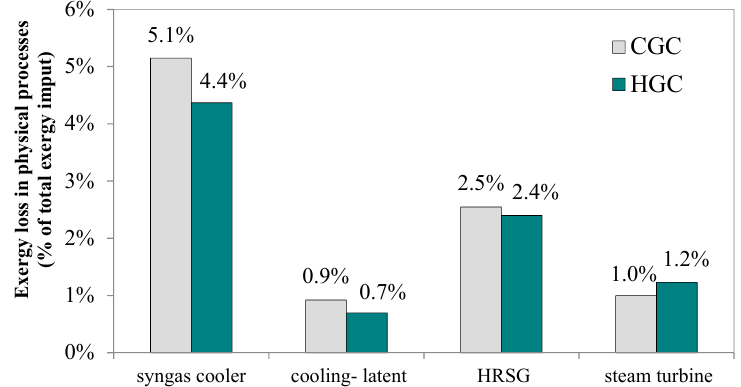
Figure 5. Exergy loss of physical processes when employing HGC.